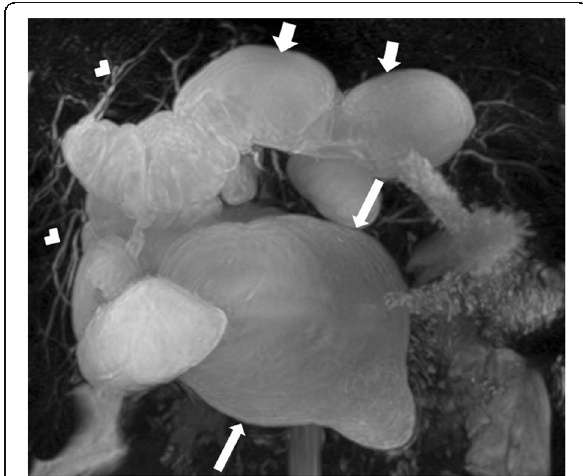
Fig. 10 A 23-year-old pregnant patient presenting with jaundice. Coronal plane MRCP MIP image shows fusiform dilation of the entire extrahepatic bile duct (long arrows) with extensive dilation of the intrahepatic bile ducts in the left lobe (short arrows). Intrahepatic bile ducts in the right lobe are normal